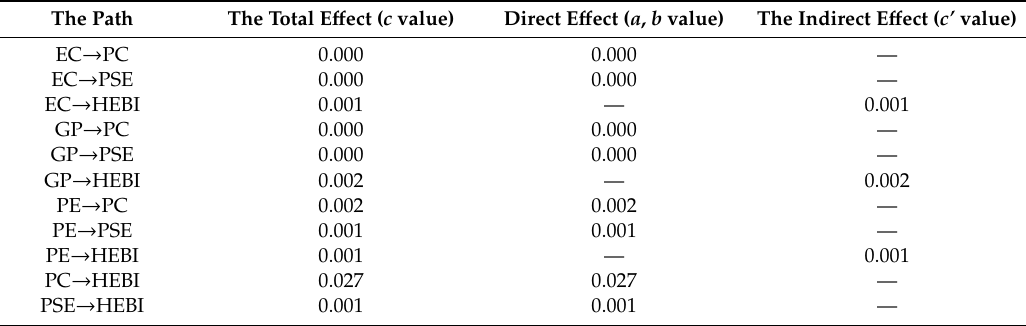
Table 6. Double-tailed test results based on BC (Bias-Corrected) method.